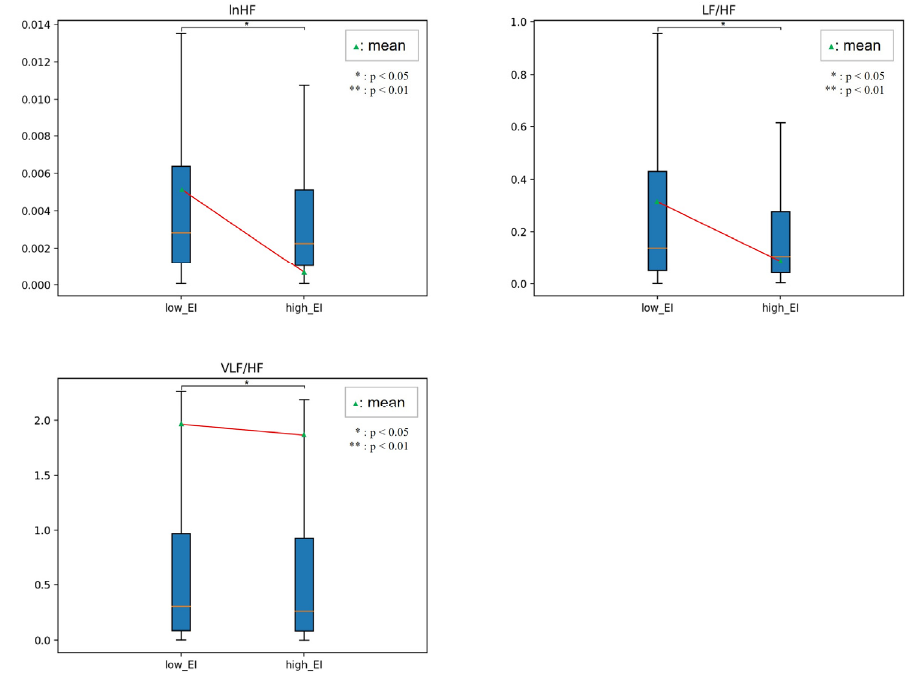
Figure 12. Comparison between low and high EI in instability.